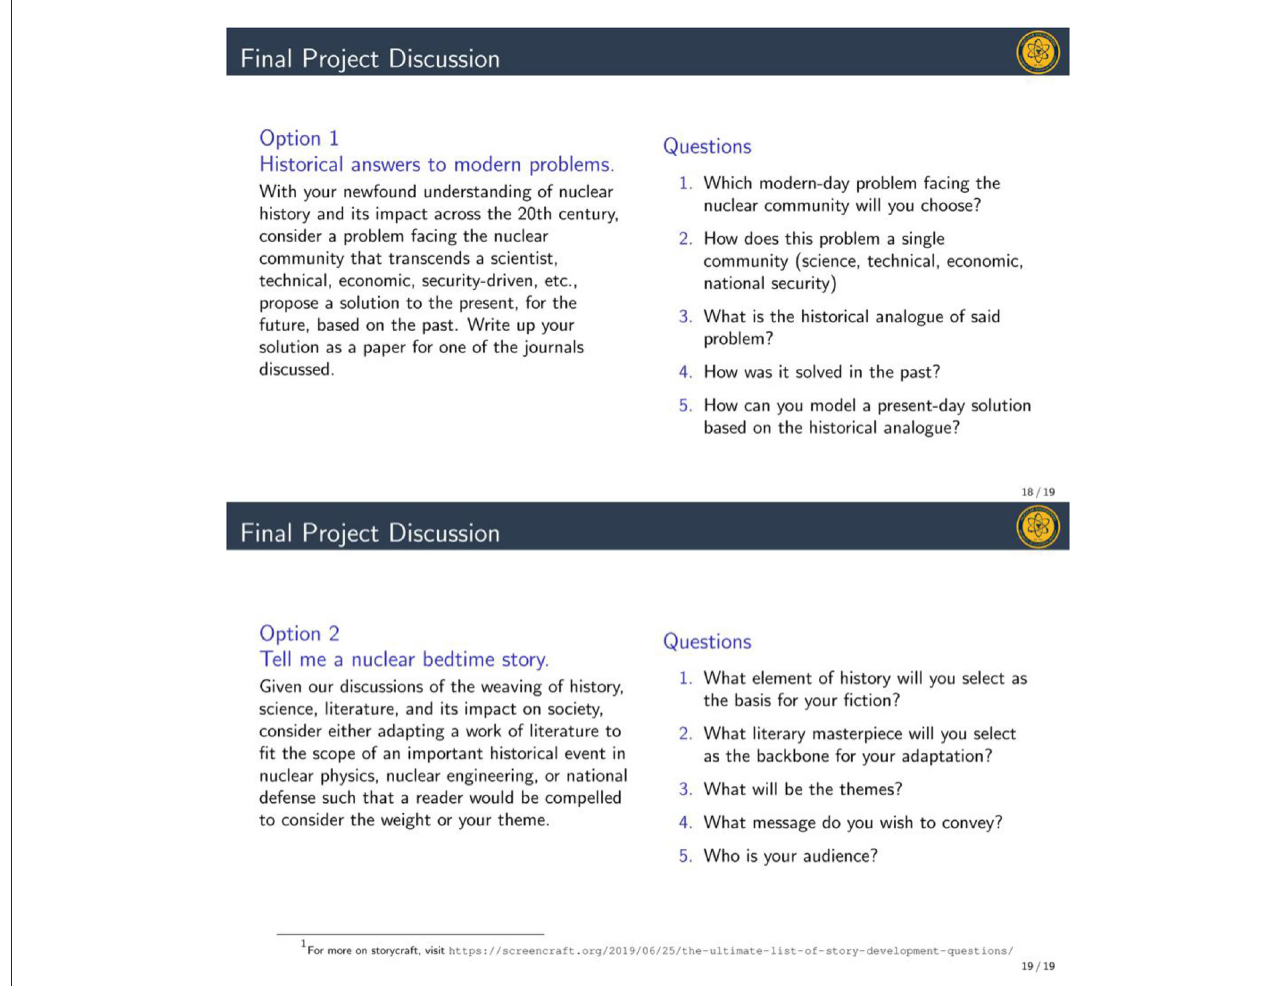
FIGURE19 Final project assignment options and corresponding initial questions from Lecture W7L13.